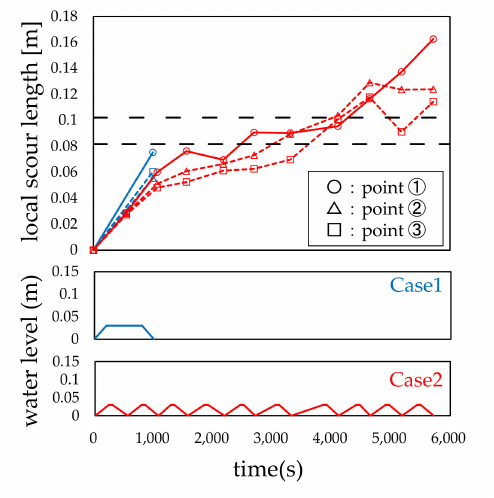
Figure 13. Local scour length of Cases 1 and 2.